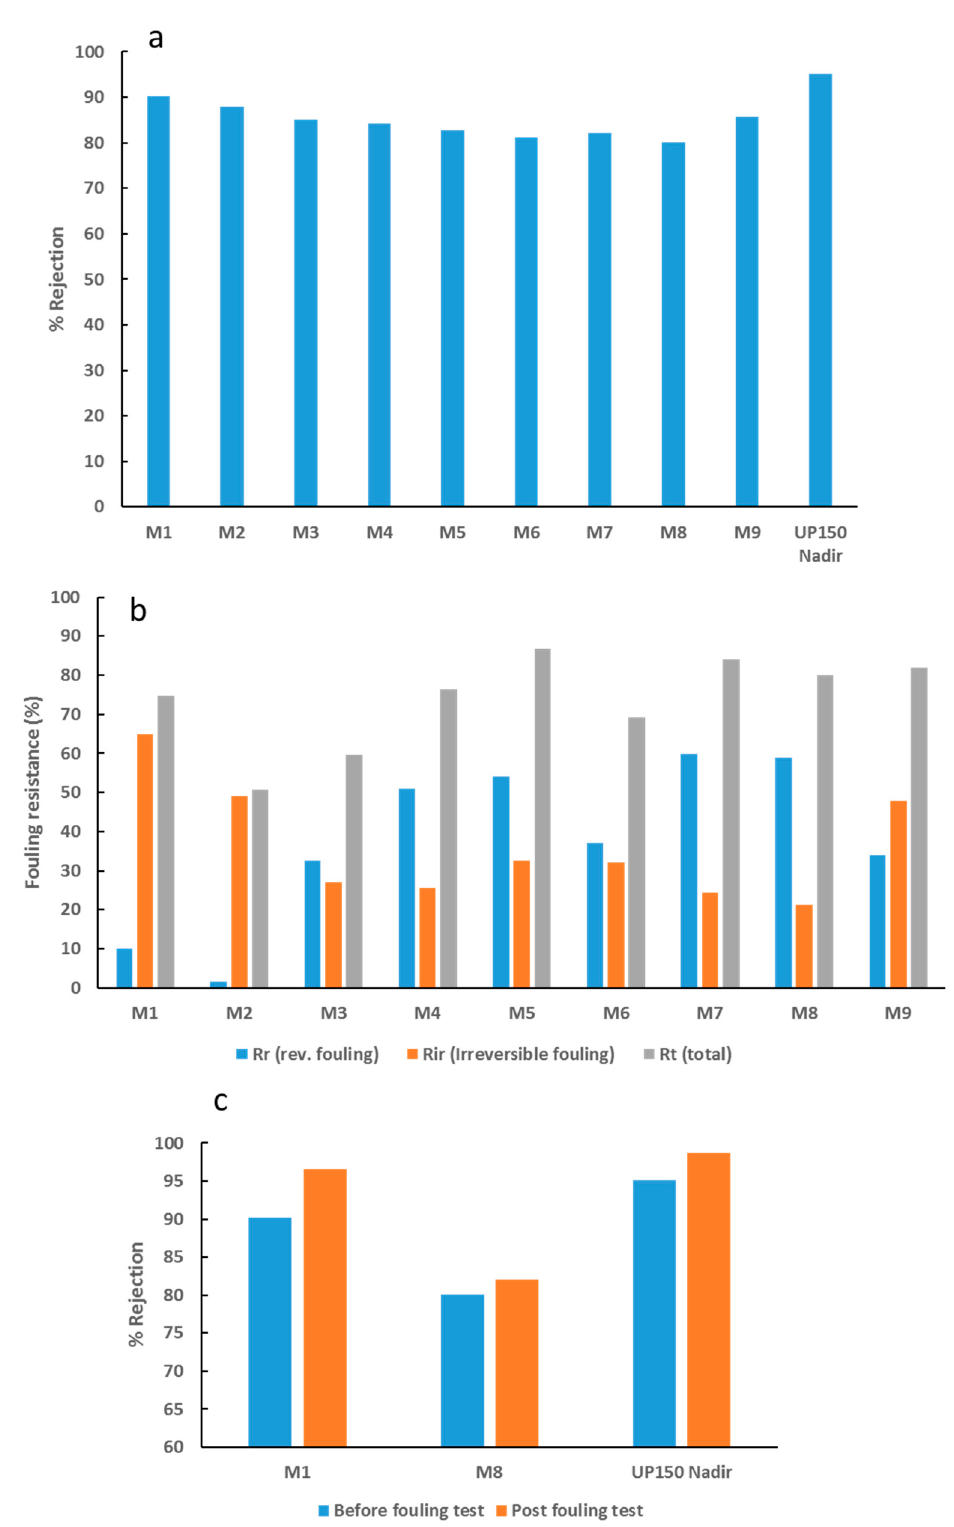
Figure 11. Rejection and fouling data for fabricated PES membranes. ( a ) BSA rejection values, ( b ) different types of membranes fouling derived from BSA solution filtration tests, and ( c ) BSA rejection values for M1, M8, and UP150 Nadir commercial membrane before and after filtration with E. coli suspension.